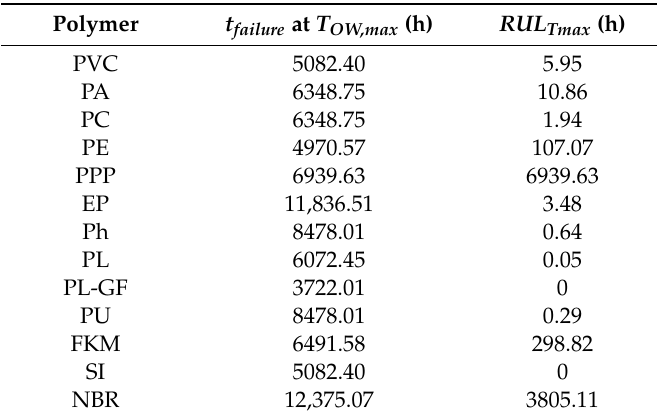
Table 3. Calculated t failure and RUL Tmax .